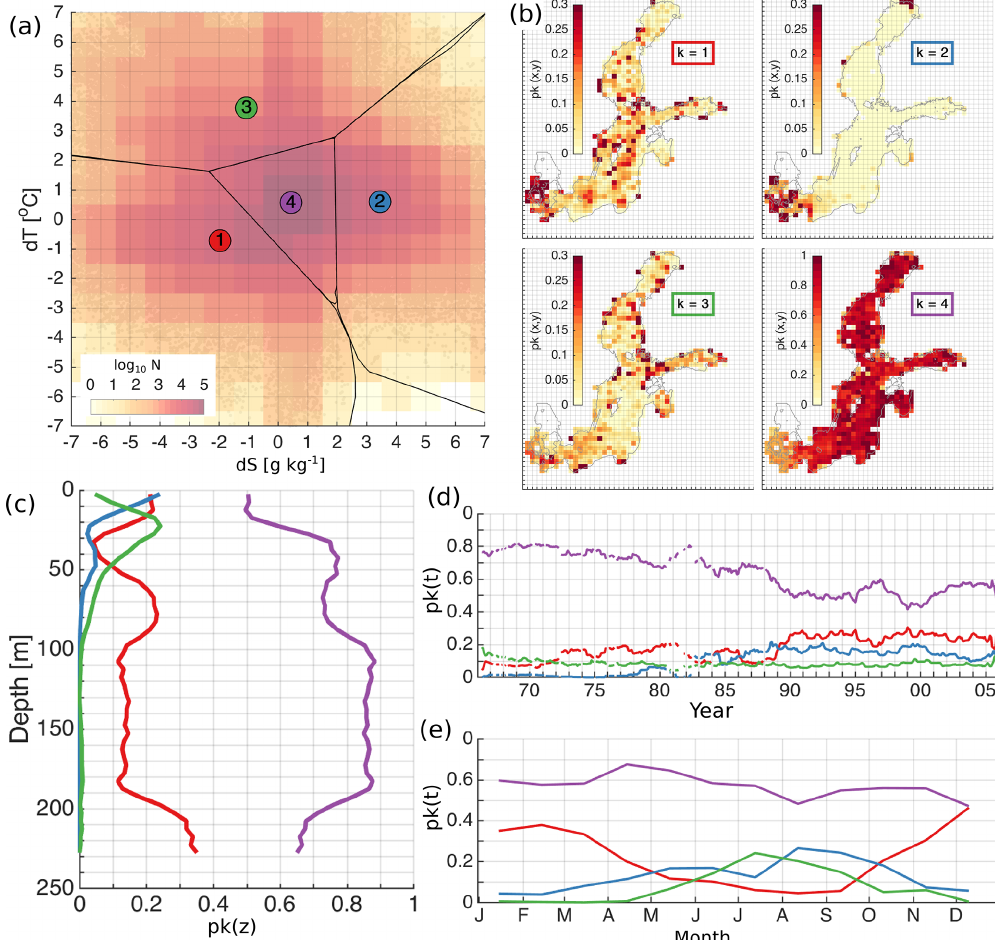
Figure 5. The distribution of the error clusters for K = 4 (a) . The coloured map shows the logarithmic distribution of the number of salinity and temperature error pairs (model minus observation) in the 2-dimensional error space (a) . Error bins have a resolution of 1 ◦ C for temperature and 1gkg − 1 for salinity (a) . The spatial (b) , vertical (c) , temporal (d) , and seasonal (e) distribution of the share of error points belonging to the four different clusters (b) . The share, p(k) , representing the share of the error points belonging to the cluster k , is calculated as explained in Sect. 2.4. The horizontal bins have a resolution of 25km × 25km (b) , vertical bins have a resolution of 5m (c) , and temporal and seasonal bins have a monthly resolution (d, e) . The lines in (d) have been smoothed using a running mean with a 12-point window size. Line colours correspond to the colours of the clusters in (a)